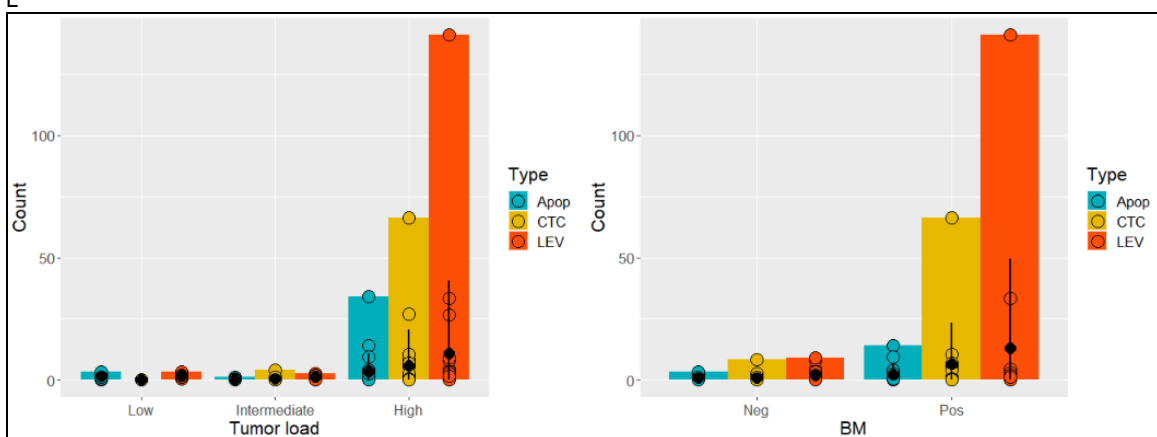
Figure 1. Identification and size determination of circulating tumor cells and LEVs. ( A ) The integrated LEV/HDSCA workflow. ( B ) Examples of objects identified in one patient, classified to different categories and verified with higher resolution (40 × ) immunofluorescence and brightfield imaging. Composite shows DAPI in blue, pan-CK in red and CD45 in green. Scale bar is 10 µ m. Arrows points to cell or LEV (DAPI-negative) for clarification. ( C ) Size distribution of LEVs, CTCs and apoptotic-like cells. ( D ) Linear regression of LEVs and CTCs with number of objects identified per slide, averaged over 2 slides analyzed per sample. ( E ) Cell/LEV enumeration grouped by tumor load (left panel) and bone marrow status (right panel). Open circles represent individual datapoints. Filled black circles and black line represent mean values and standard deviations,